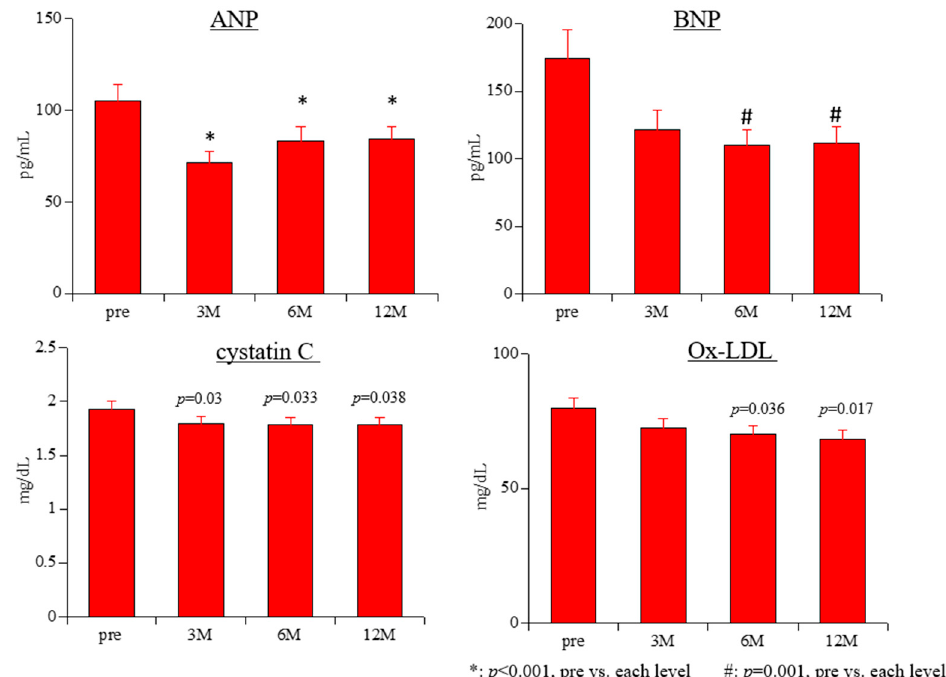
Figure 2. Changes in the levels of atrial natriuretic peptide, B-type natriuretic peptide, cystatin C, and oxidized low-density lipoprotein over 12 months of treatment with continuous erythropoietin receptor activator. ANP, atrial natriuretic peptide; BNP, B-type natriuretic peptide; Ox-LDL, oxidized low-density lipoprotein.